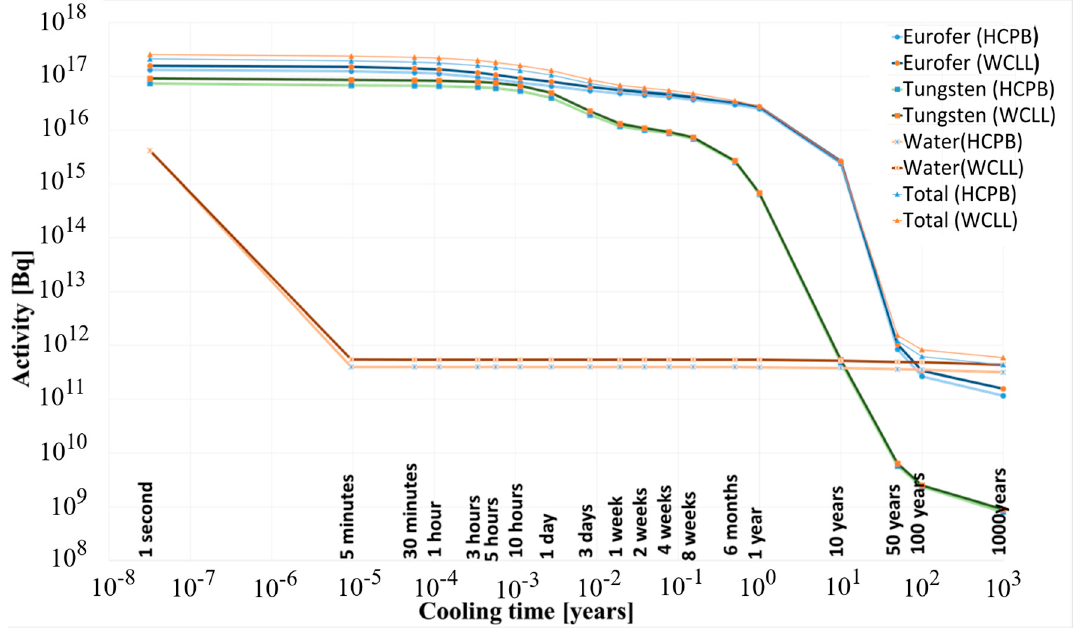
Figure 9. Activation in the liner and reflector plates of HCPB and WCLL concepts.